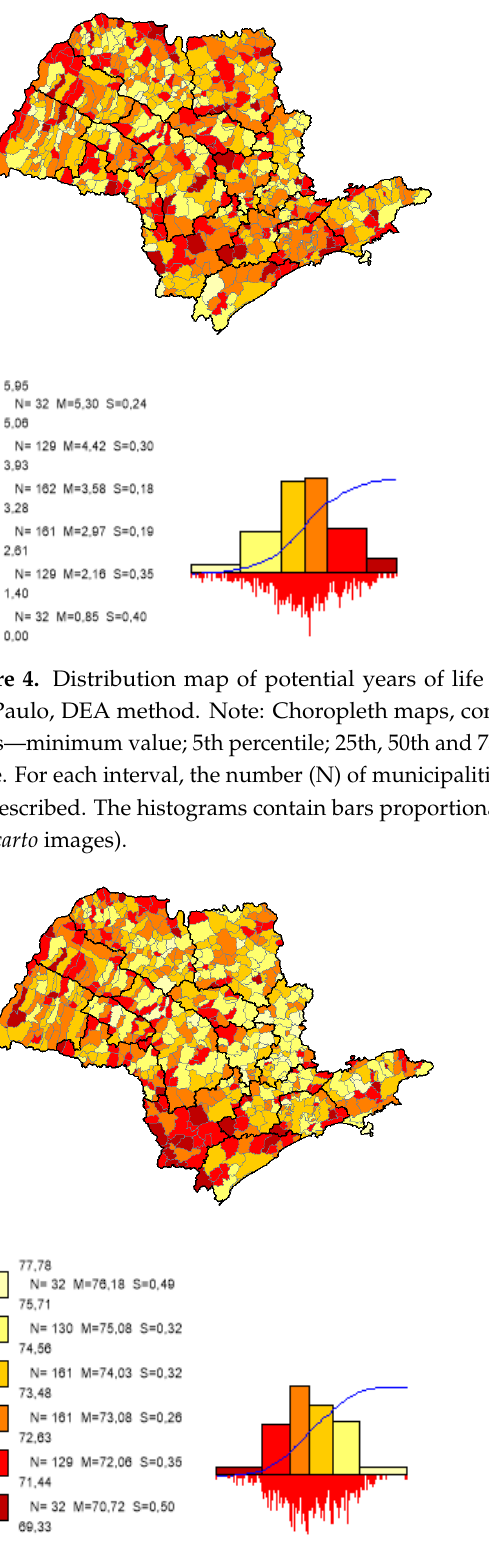
Figure 5. Distribution map of Life Expectancy, average results in the municipalities of the state of SP. Note: Choropleth maps, consisting of six divisions, using the following limits—minimum value; 5th percentile; 25th, 50th and 75th percentiles; 95th percentile and maximum value. For each interval, the number (N) of municipalities, their mean (M) and standard deviation (S) are described. The histograms contain bars proportional to the number of localities in each division ( Philcarto images).